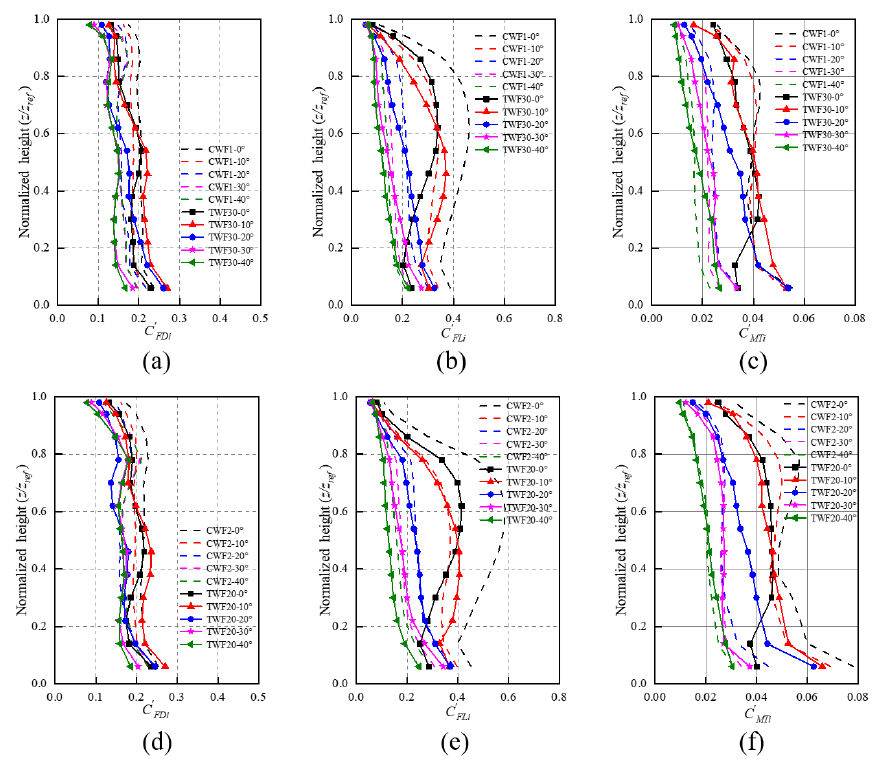
Figure 14. Variations of 𝐶 (cid:3007)(cid:3005)(cid:3036)(cid:4593) , 𝐶 (cid:3007)(cid:3013)(cid:3036)(cid:4593) , and 𝐶 (cid:3014)(cid:3021)(cid:3036)(cid:4593) with height: ( a – c ) in TWF30 and CWF1; and ( d – f ) in TWF20 and CWF2.